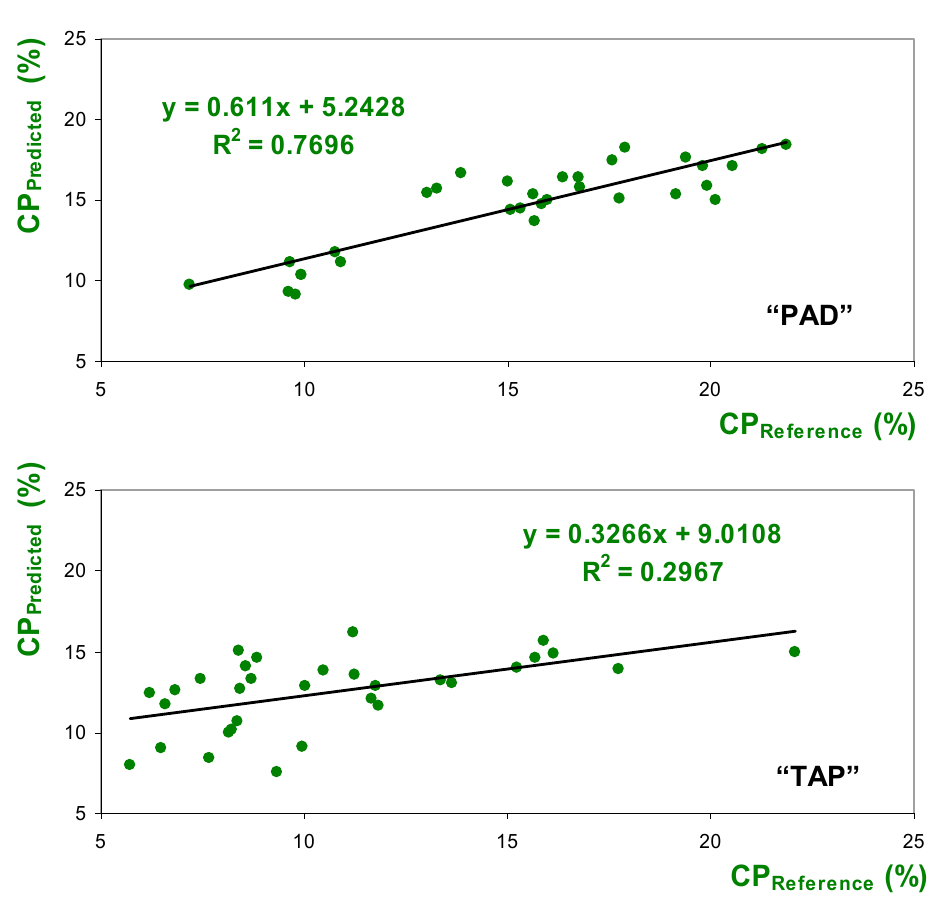
Figure 10. Reference values of pasture moisture content (PMC), crude protein (CP) and neutral detergent fiber (NDF) obtained in laboratory versus normalized difference vegetation index (NDVI) measurements carried out by the optical sensor OptRx.